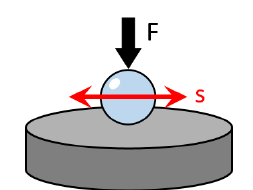
Figure 7. Ball-on-disc tribometer